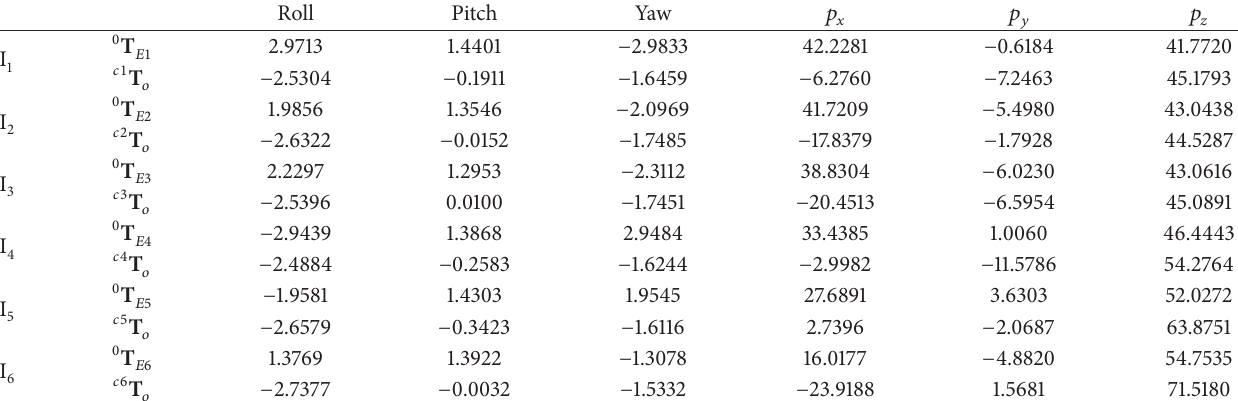
Table 5: The pose information corresponding to known movements of the generalized